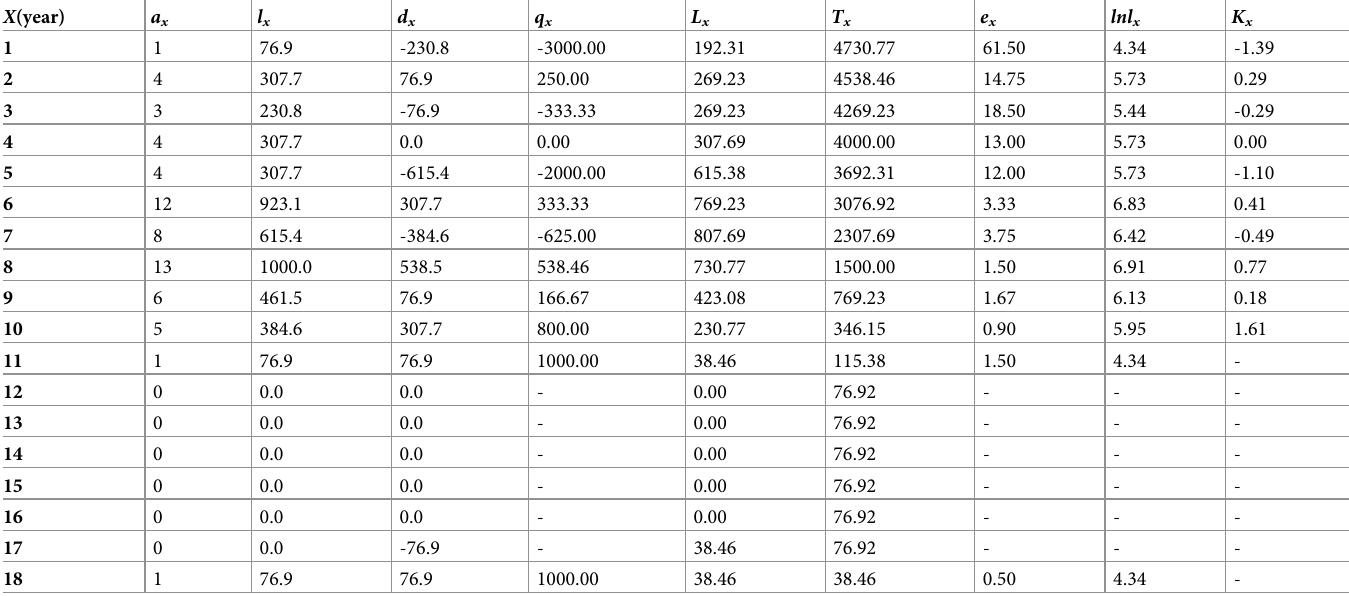
Table 2. Time-specific life table of P . flavus WM population.